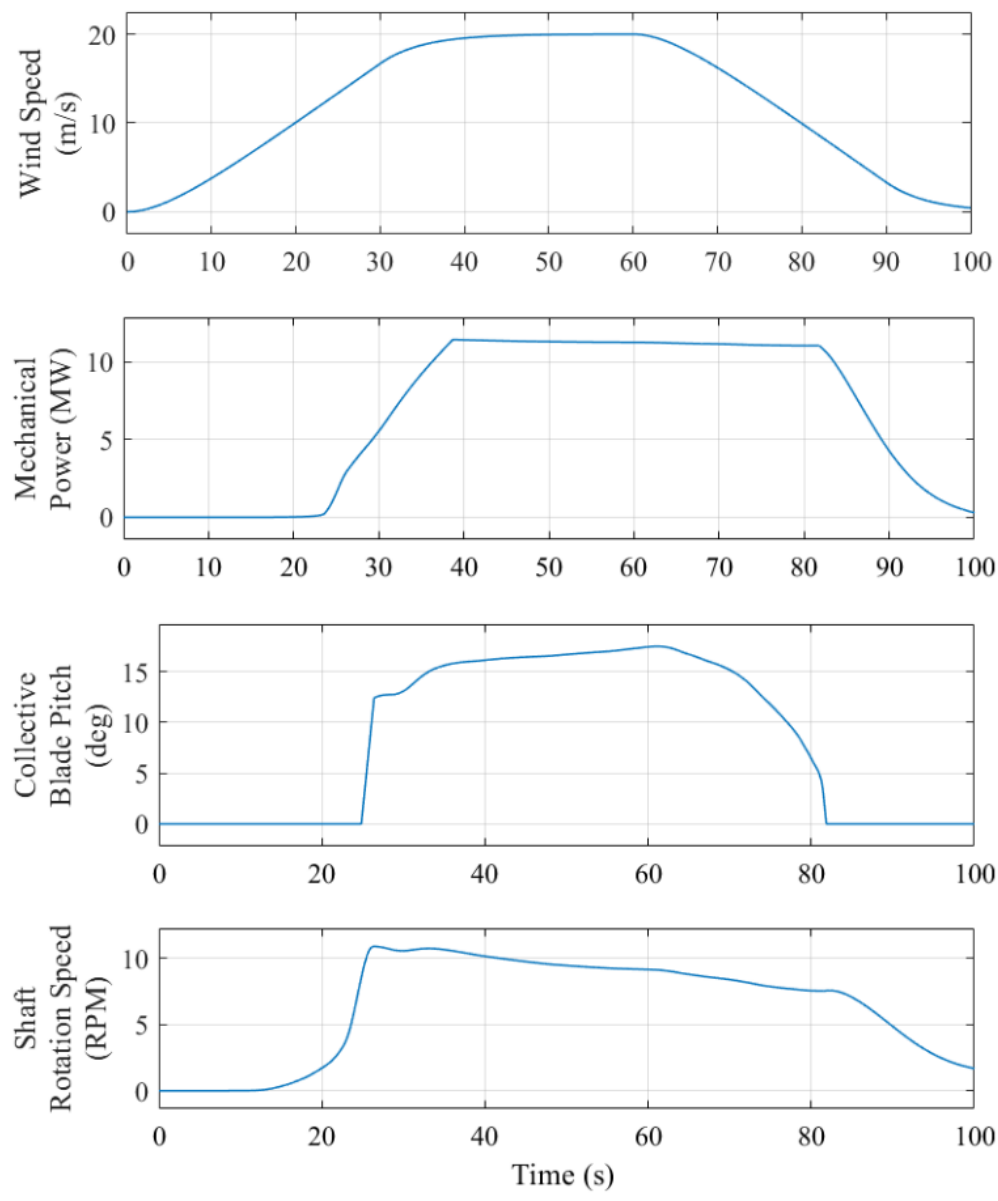
Figure 4. Wind speed and shaft speed scenario used for the case study in Section 3.3.